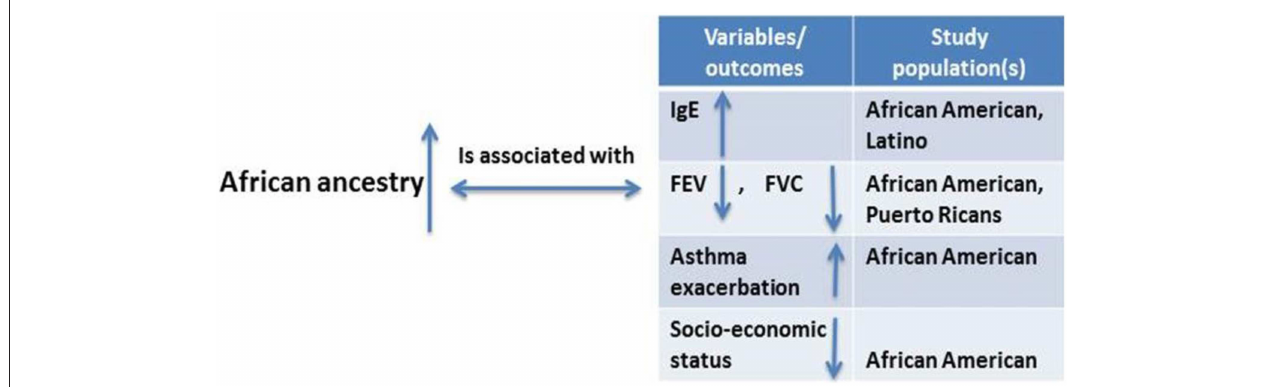
FIGURE 6 | Studies considering the relationship between degrees of African ancestry proportion and asthma and asthma-related outcomes.